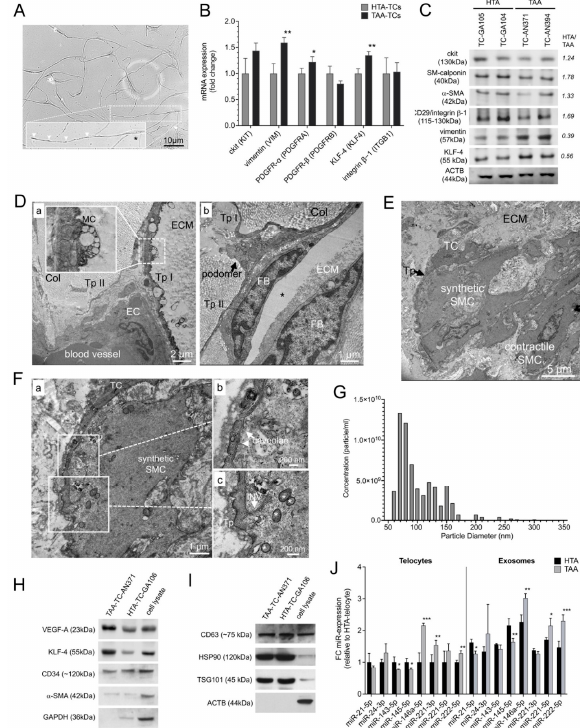
Figure 2. Characterization of isolated and sorted TCs and exosomes from HTA ( n = 23) and TAA ( n = 29) specimens. ( A ) Representative image of isolated and CD34 + /ckit + sorted TCs from aortic tissue. In the magnification TC showed typical morphology with oval cell body (Asterisc), long thin processes including intermitted telopodes (arrows) shown by light microscopy 14 days after isolation. ( B ) mRNA expression profile of aortic TC marker genes ( KIT , VIM , PDGFRA , PDGFRB , KLF4 , and ITGB1 ) confirmed TC phenotype and showed differences between cells isolated from healthy aortic specimens (HTA-TCs, n = 10) compared to aneurysmal aortic specimens (TAA-TCs, n = 10). Bars indicate the relative expression of each mRNA normalized to GAPDH and RPLP0 . Data are mean ± SD of three independent experiments. ( C ) Western blot analysis of TCs isolated from two individual HTA-aortic samples and two from TAA-aortic samples. Six protein markers which are involved in phenotype switching of SMCs were analyzed (ckit, SM-calponin, α -SMA, CD29/integrin ® -1, and KLF-4). ACTB was used as loading control; Primary antibodies and the observed molecular weight (kDa) are given on the left. Statistical calculation given by HTA/TAA ratio are given on the right. ( D – F ) Representative transmission electron micrographs of medial layer in human aortic specimens. The connections between TCs and ( D - a ) endothelial cell (EC), and ( D - b ) fibroblast (FB) embedded between collagen fibers (Col) is shown. Preparation artifact (Asterix). ( E ) Cell convergence of TC and vSMC from synthetic phenotype is shown. vSMC-phenotype was characterized by their found intracellular filament order. ( F ) Magnifications of TC telopode (Tp) to synthetic vSMC ( a ) revealed active intake of caveolae ( b ) and invaginated telopode (INV) and mitochondria (asterisks) by vSMC ( c ). MC, multivesicular cargos; ECM, extracellular matrix; TC, telocyte. ( G ) The quality, concentration (particle per ml) and particle diameter (nm) of exosomes was confirmed by qNano analysis (Izon instrument, UK) ( n = 7). ( H , I ) Representative western blots of isolated HTA- and TAA-exosomes are shown. Cell lysate was used as control. Exosome-specific soluble factors (VEGF-A, KLF-4, CD34 and α -SMA) ( H ) as well as surface proteins (CD63, HSP90 and TSG101) ( I ) were analyzed. ACTB and GAPDH were used as loading control; Primary antibodies and the observed molecular weight (kDa) are given on the left of each blot. ( J ) Micro RNA (miR) expression profile in HTA (black, n = 23) and TAA (grey, n = 29) isolated exosomes. Expression of some miR which are involved in SMC-phenotype switching were measured by qRT-PCR. Bars indicate the relative expression of each miR normalized to U6 small nuclear RNA ( RNU6B ) and SNORD44 . Data are mean ± SD of two independent experiments. * p < 0.05; ** p < 0.01; *** p <